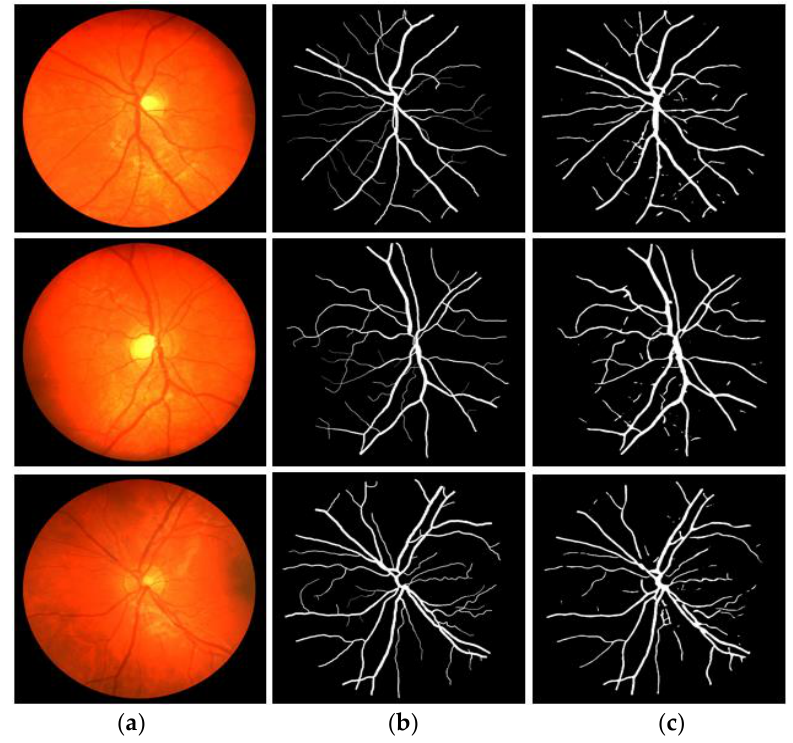
Figure 8. VSUL-Net visual results for the CHASE-DB1 dataset: ( a ) original fundus image, ( b ) expert annotation, and ( c ) VSUL-Net predicted mask.